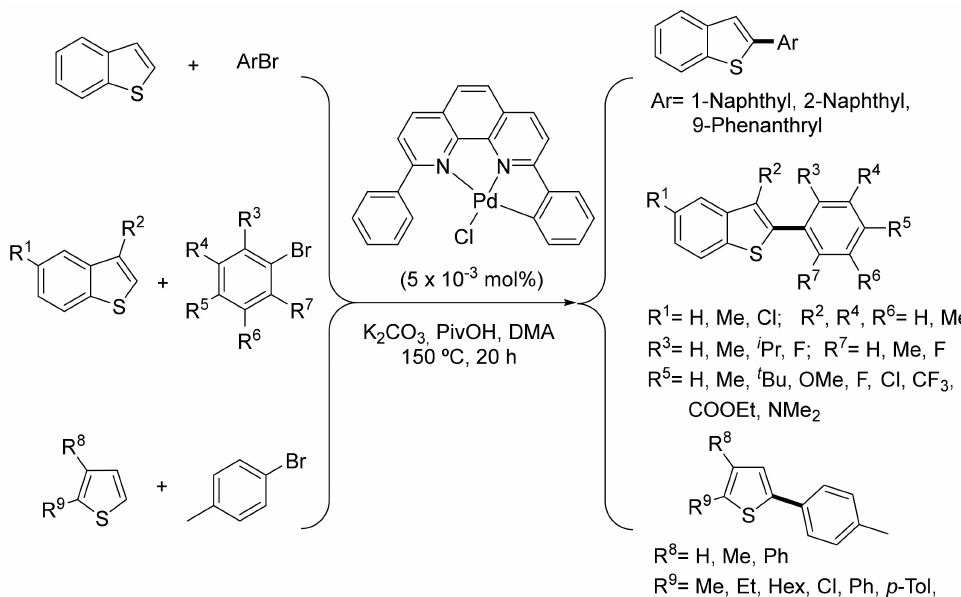
Scheme 15. Direct arylation of thiophene derivatives in the presence of a CNN